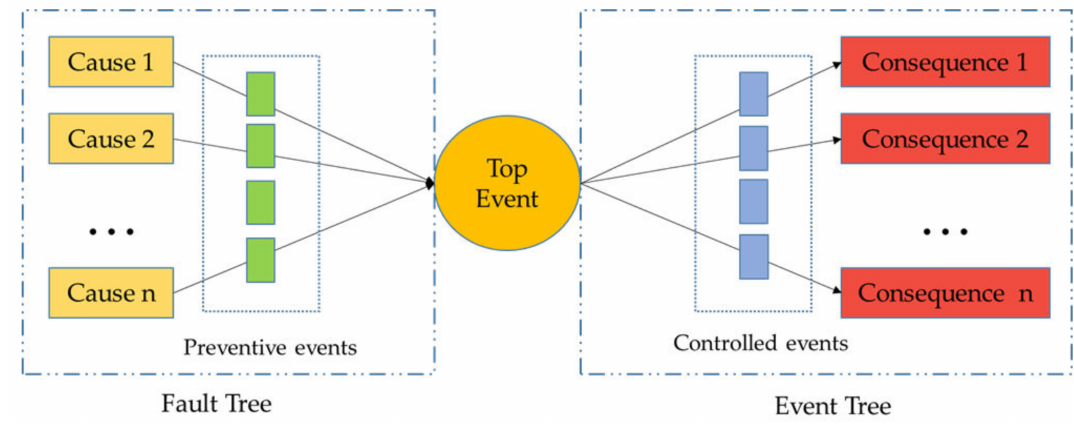
Figure 3. Basic Bow-tie